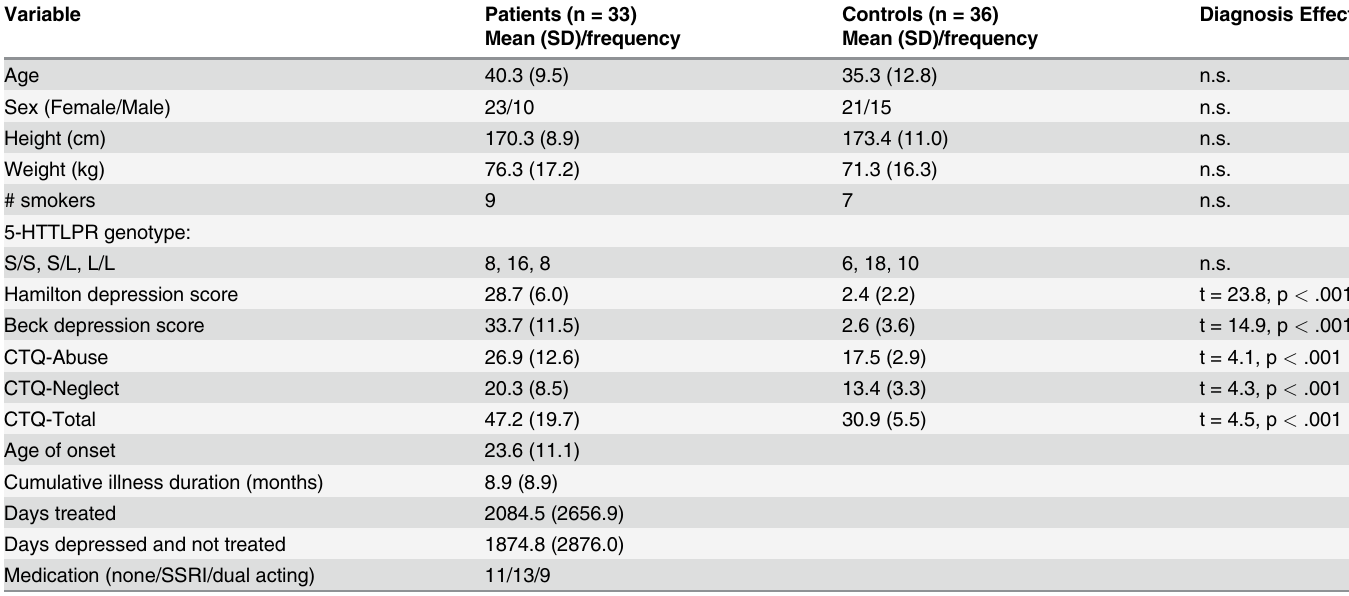
Table 1. Characteristics of the sample.